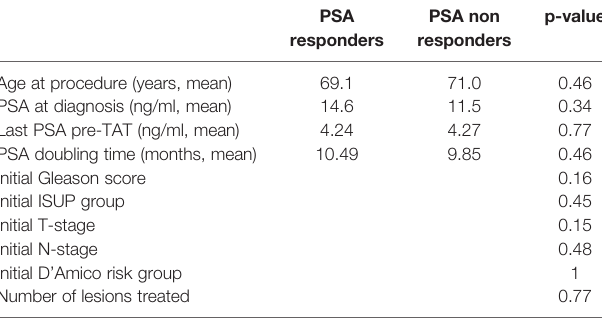
TABLE 2 | Statistical comparison of initial and pre-procedure data between PSA responders and non-responders.